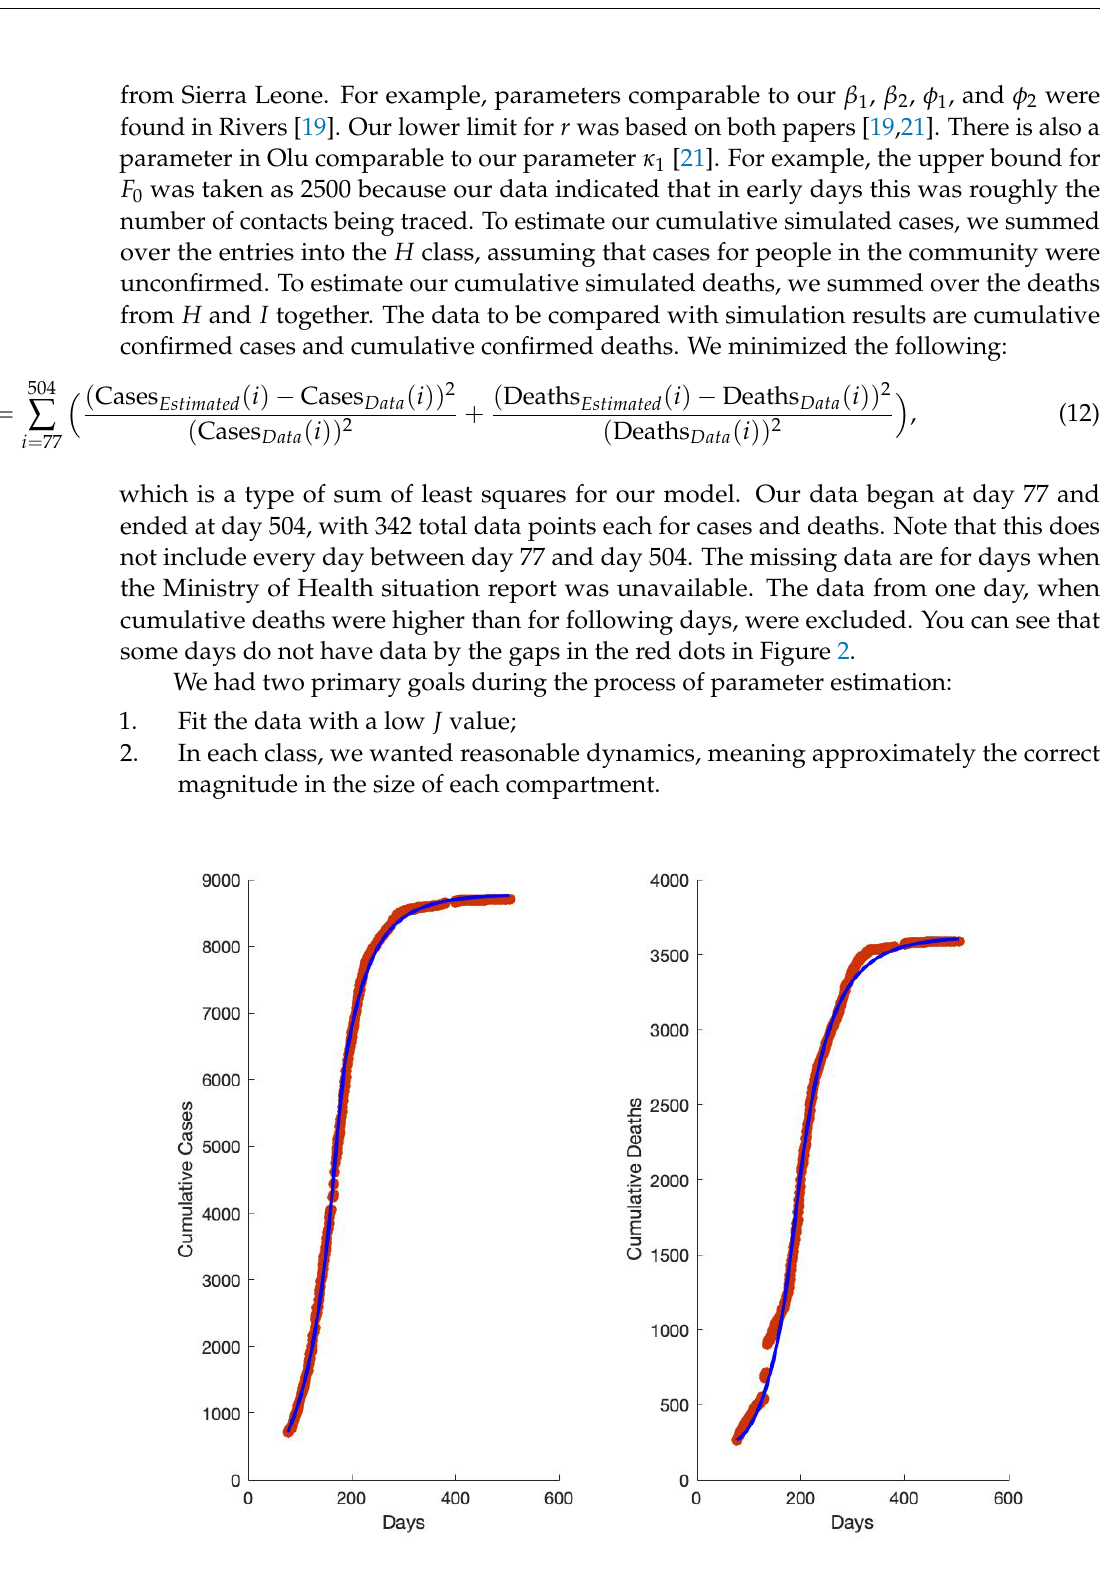
Figure 2. The value of the objective for this simulation was J =